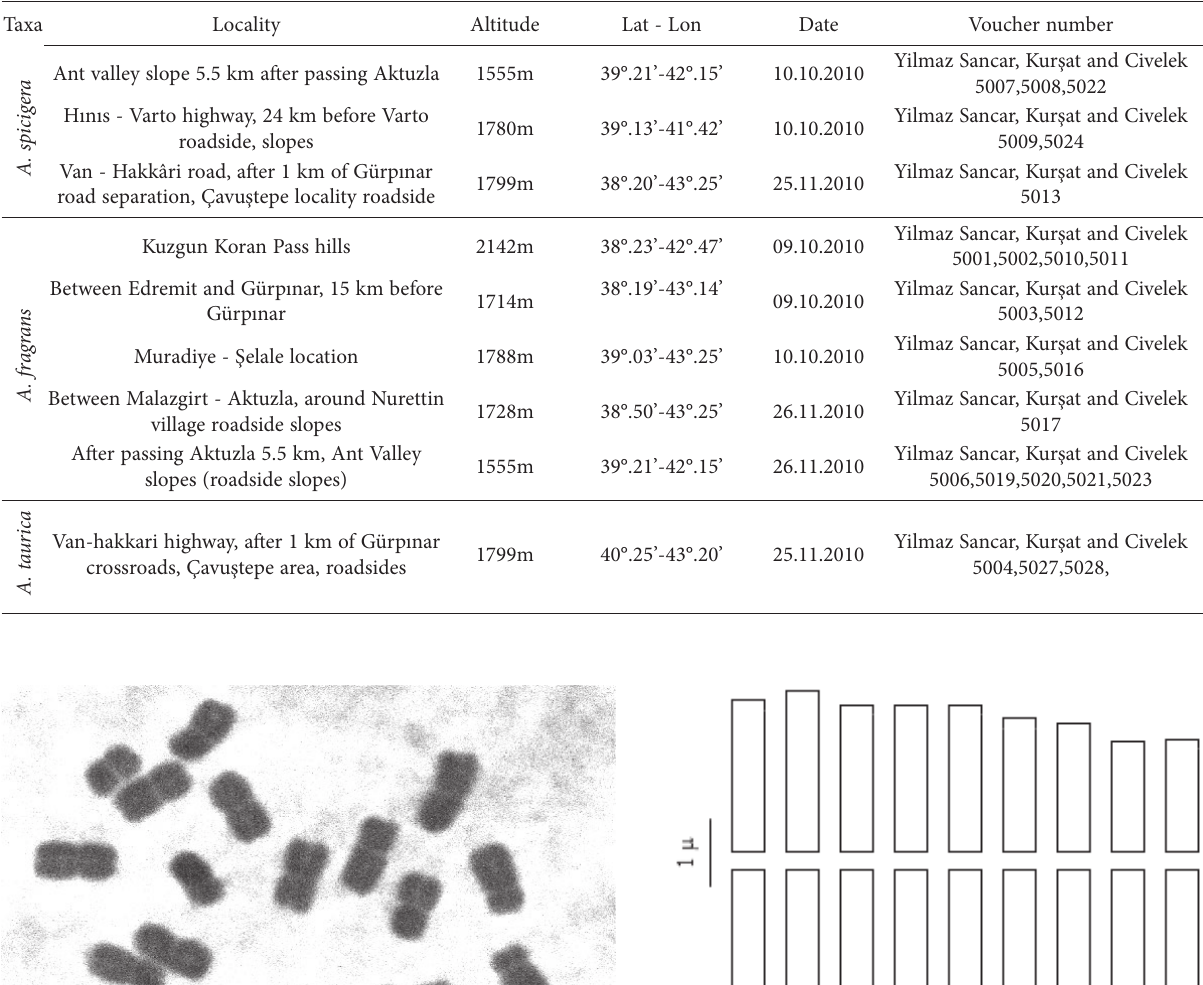
Table 1. Information of Artemisia populations location in field.